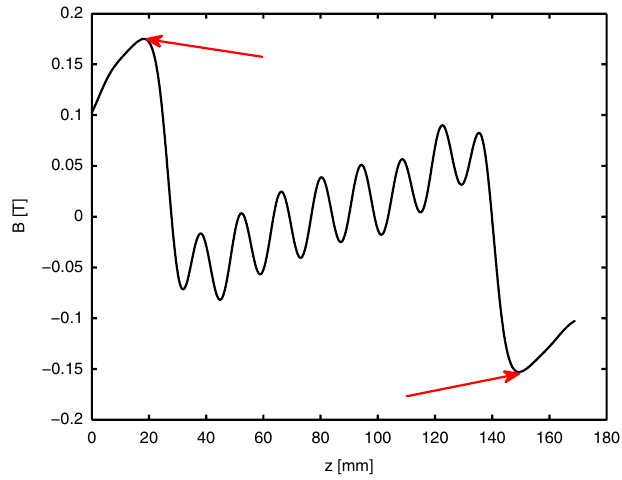
FIG. 2. (Color) The distorted magnetic field strength of an undulator mock-up before applying the induction-shimming concept. The field is significantly deformed by the end plates marked by the arrows. The period length of the undulator mock- up is 14 mm.